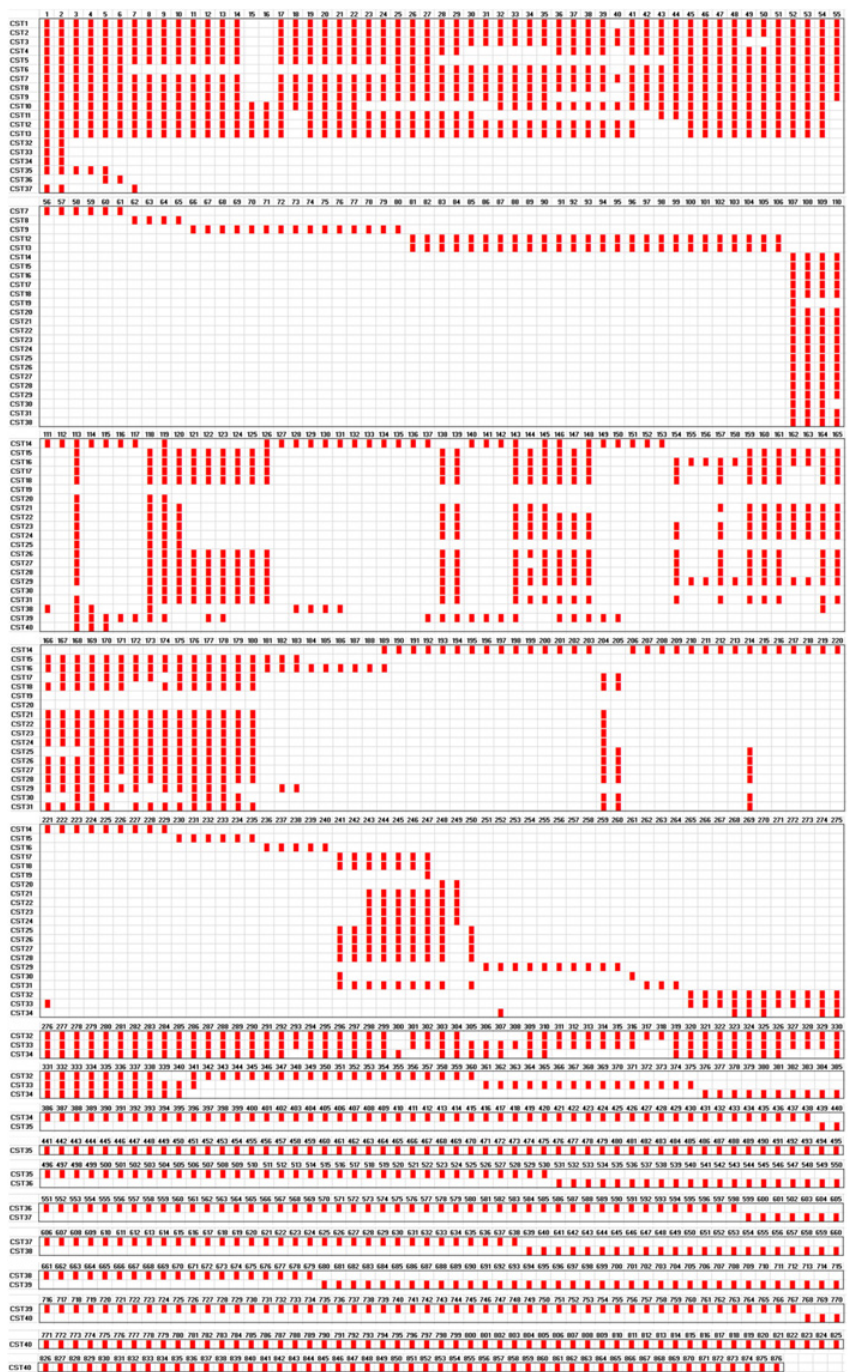
Fig 4. Graphic representation of the arrays of spacers in the CRISPR- cas subtype I-Fb locus of Acinetobacter baumannii . The figure demonstrated the assortment of 74 A . baumannii isolates into 40 CRISPR sequence types (CST) based on the spacer content of their CRISPR arrays. Spacers were represented by red rectangles. Each unique spacer was assigned a number (1 – 876). Spacers were sequentially aligned in order to facilitate comparison among the